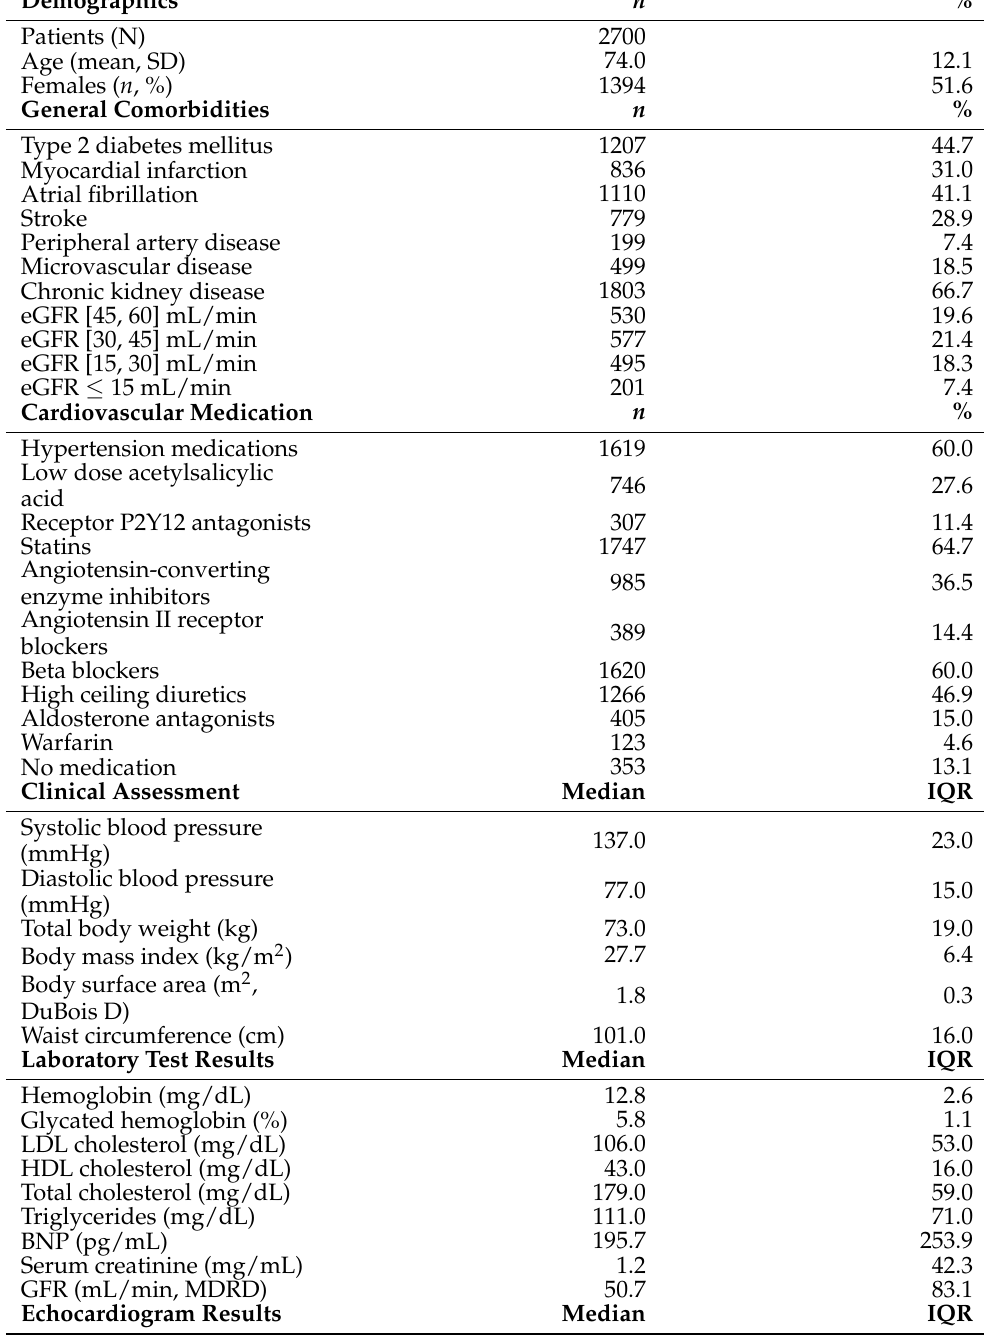
Table 1. Demographics, comorbidities, cardiovascular medications, clinical assessment, and echocar- diogram results of the heart failure